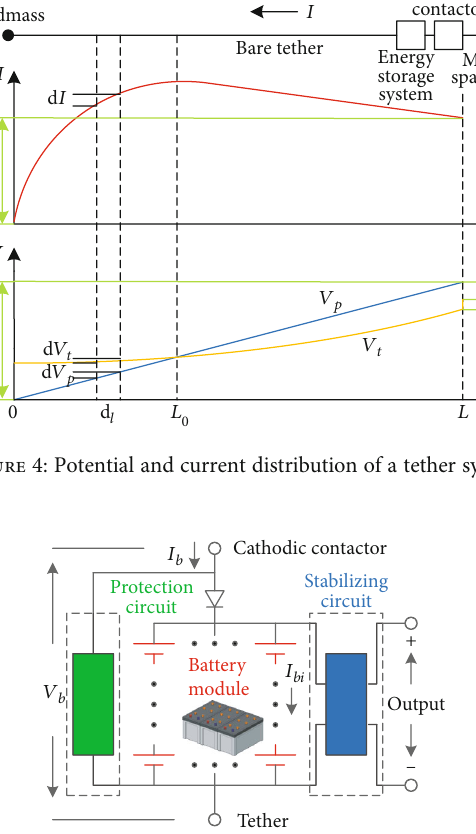
Figure 5: Schematic of the Li-ion battery